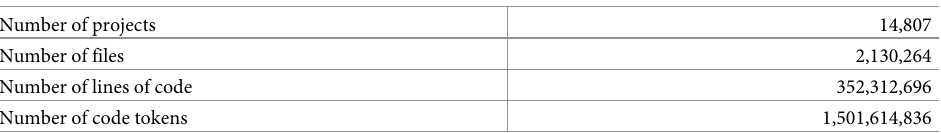
Table 1. Dataset